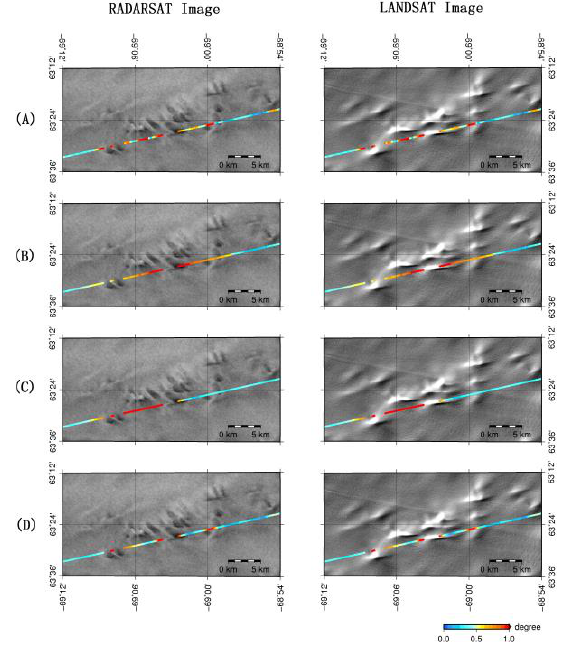
Figure 5. LANDSAT image and slopes of ICESat track derived from repeat-track method (A), RAMP DEM (B), Bamber DEM (C) and ICESat DEM (D).